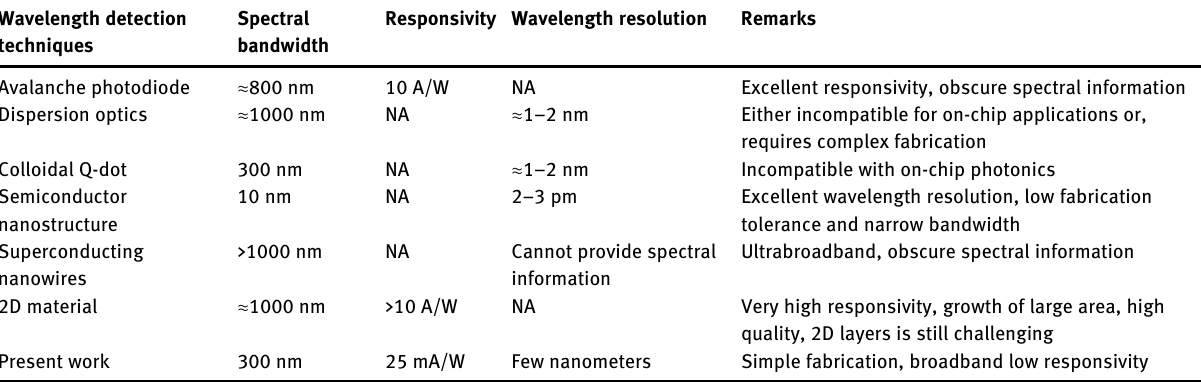
Table  : Comparison of different wavelength detection techniques [  –  ,  – 